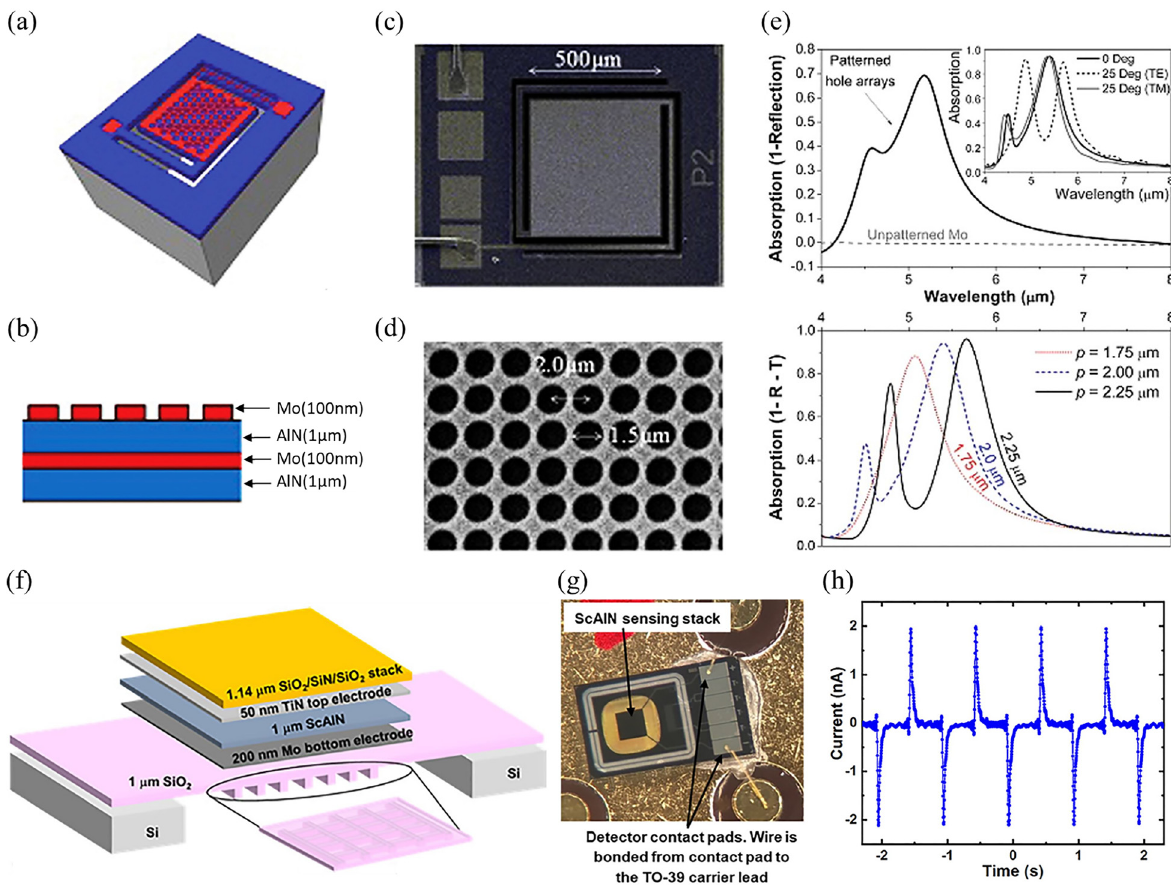
Figure 7: AlN-based pyroelectric photodetector. (a) and (b): Schematicandcross-sectionof the wavelength-selective pyroelectricsensor. (c) and (d): SEM images of the fabricated